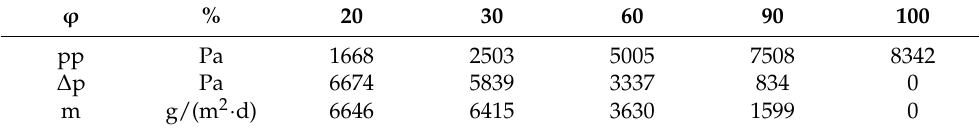
Table 3. Defined and measured parameters of a sample’s vapour permeability (40 ◦ C). ϕ